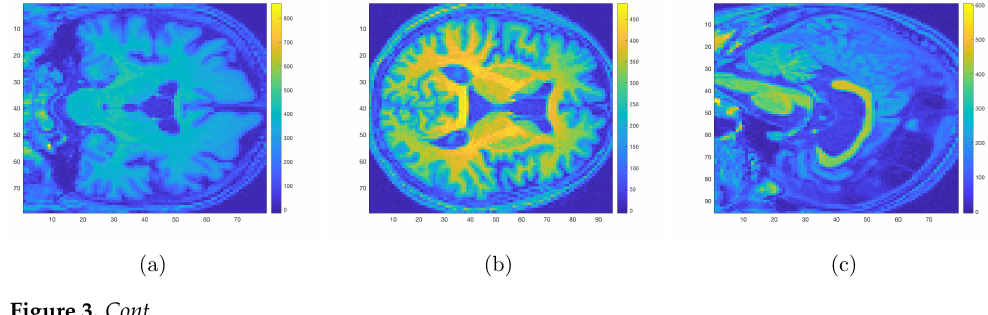
Figure 2. Three-dimensional sMRI images for NDPD ( a – c ), HC ( d – f ), and the heatmaps for coefficient matrices corresponding to three different surfaces respectively ( g – i ). Voxels with yellow and dark blue colors correspond to regions with aberrant structural changes for NDPD compared with HC.